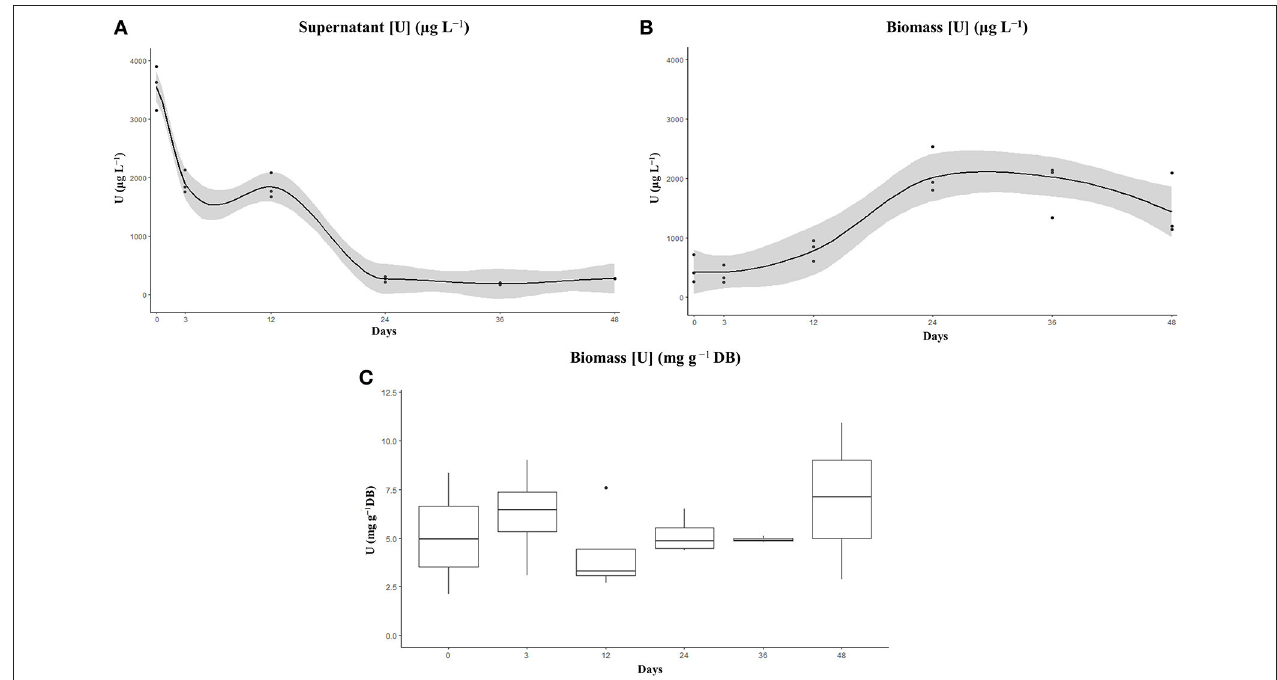
FIGURE 5 | Elimination (recovery) (A) and cell uptake (B) of U from BG-11 medium supplemented with 4mg U L − 1 by the artificially selected ChlSG strain after 48 days in free suspension. The amount of U significantly decreased in the supernatant (A) and the biomass (B) showed a positive slope in the U uptake over time. No significant differences can be observed in terms of U uptake g − 1 DB over time (C) , with a mean value of ∼ 6mg U g − 1 DB of